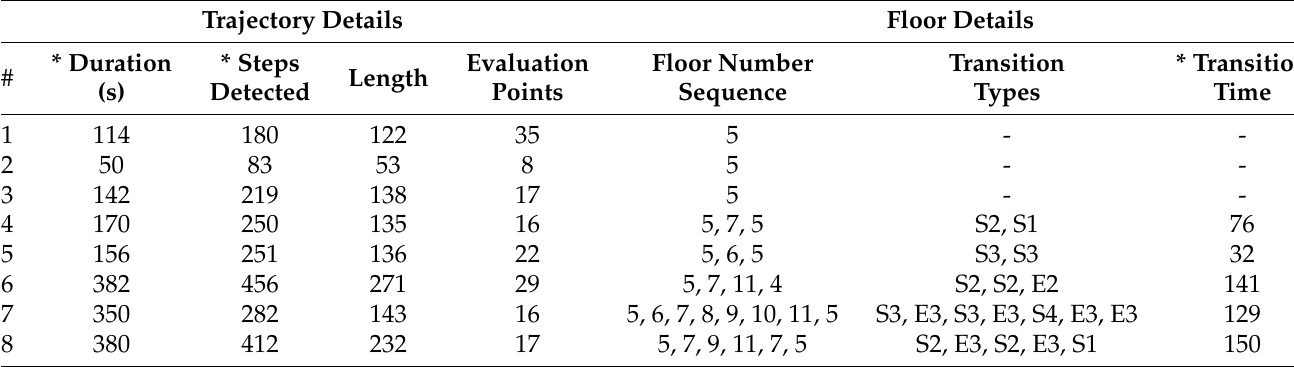
Table 2. Evaluation trajectory information. Each trajectory was repeated four times. “S” and “E” stand for stairs and elevator, respectively. * means the values are